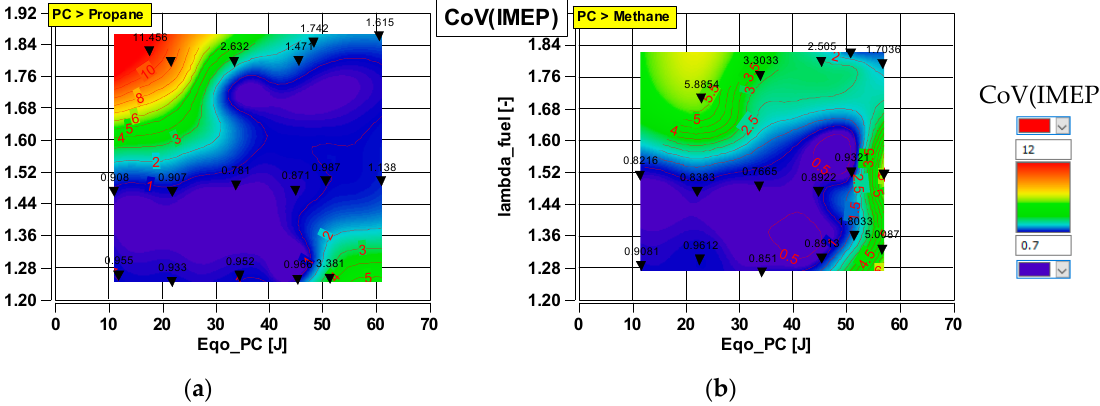
Figure 5. Interpolated maps showing the stability of engine operation represented by the coe ffi cient of variation CoV(IMEP): ( a ) when burning propane in the prechamber; ( b ) when burning methane in the prechamber.